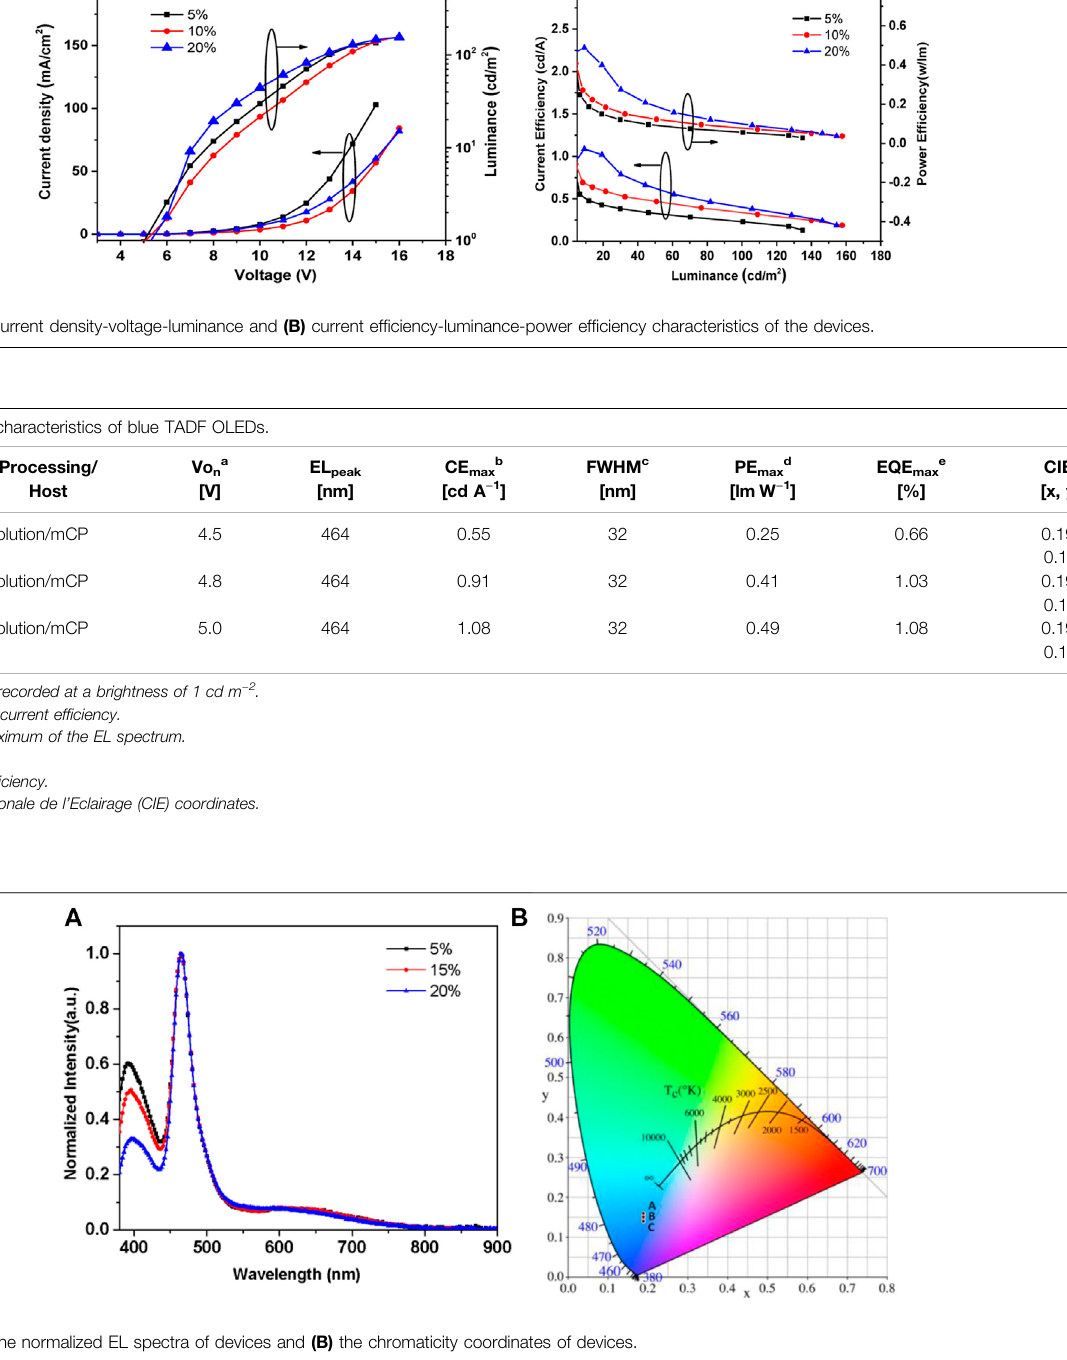
Frontiers in Chemistry |